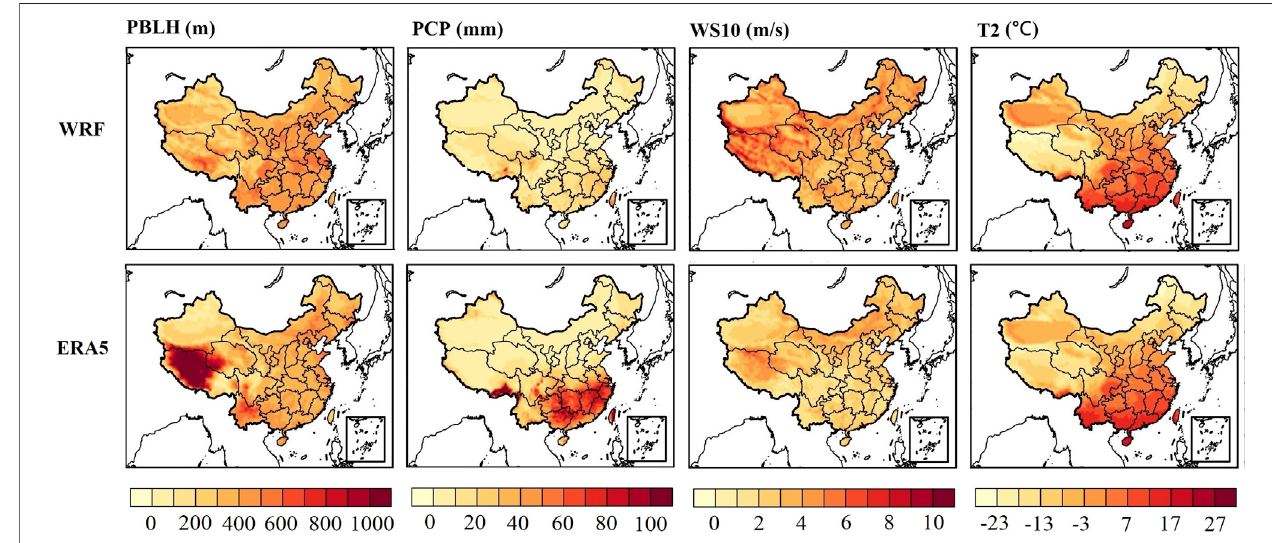
FIGURE 2 | Comparisons of meteorological fi elds from Basecase simulations and ERA5 data.